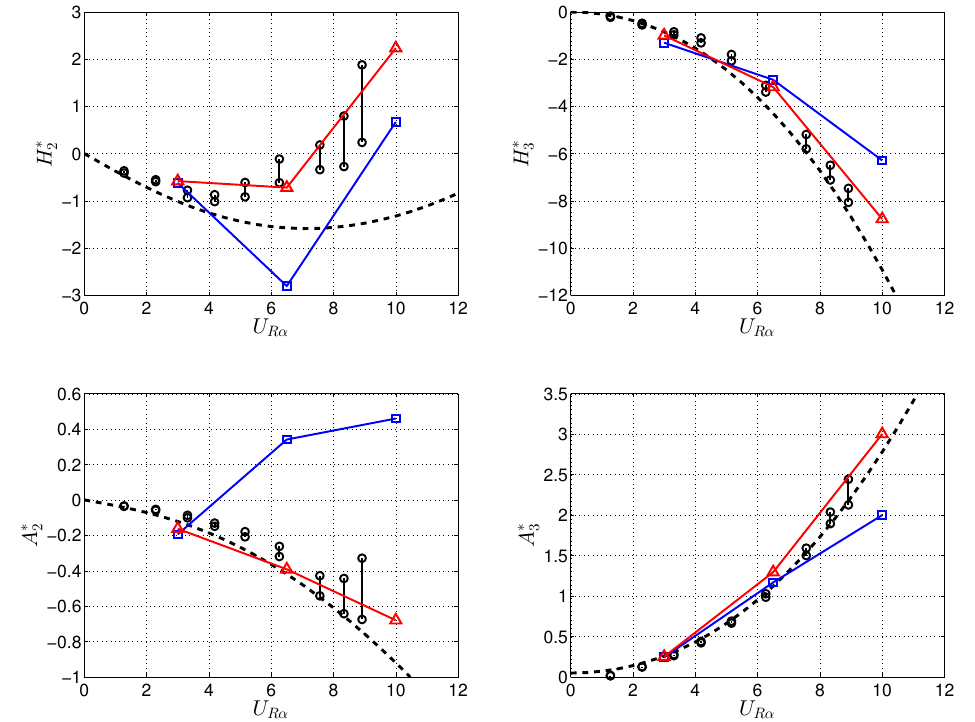
Figure 23. Computed and measured flutter derivatives for the bridge section. R/B = 0 and 0.05 denote, respectively, sharp and smooth lower edges. Experimental data from [55,62] in the form of 95% confidence intervals. The usual sign convention of bridge aerodynamics was adopted here, i.e. , that of Figure 17 but with the lift force positive